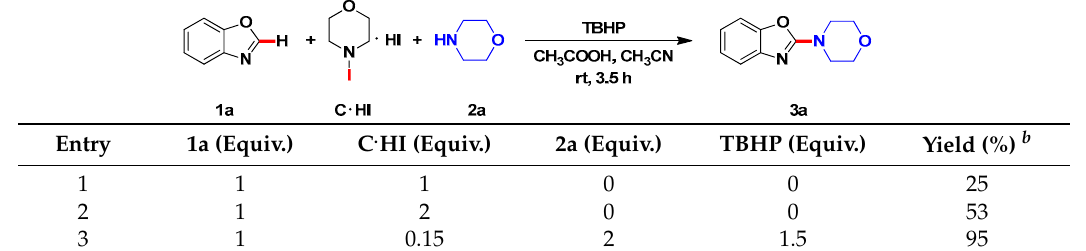
Table 2. Reactivity of N -Iodomorpholine Hydroiodide C . HI a .